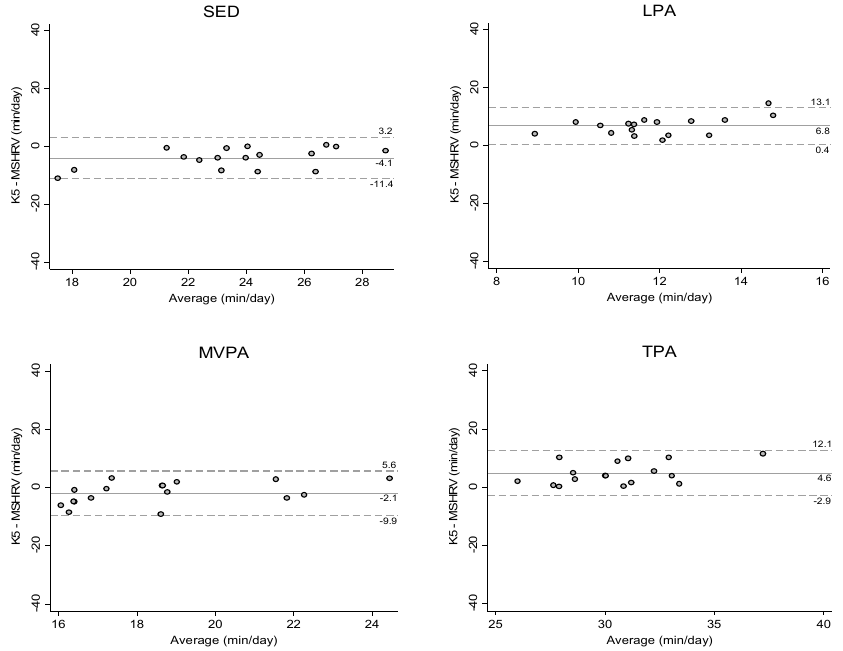
Figure 4. Bland–Altman plots illustrating the level of agreement in sedentary behavior and PA estimates between the Cosmed K5 and MotionSense HRV (MSHRV) under simulated free-living conditions. Dashed lines show 95% limits of agreement ( ± 1.96 standard deviation). SED: sedentary behavior; LPA: light PA; MVPA: moderate ‐ to ‐ vigorous PA; TPA: total PA.